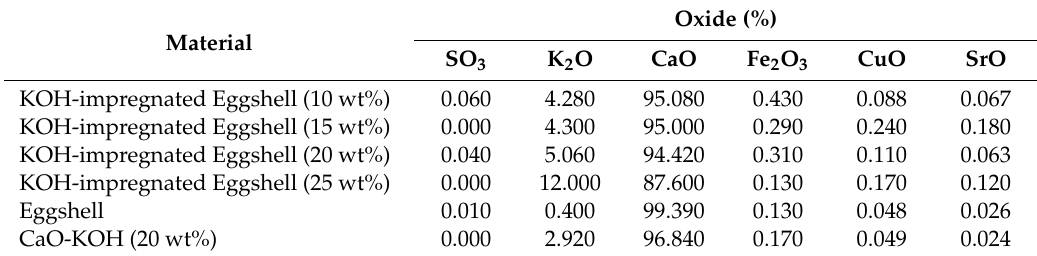
Table 1. Chemical composition (wt%) of eggshell and KOH-impregnated eggshell. Material